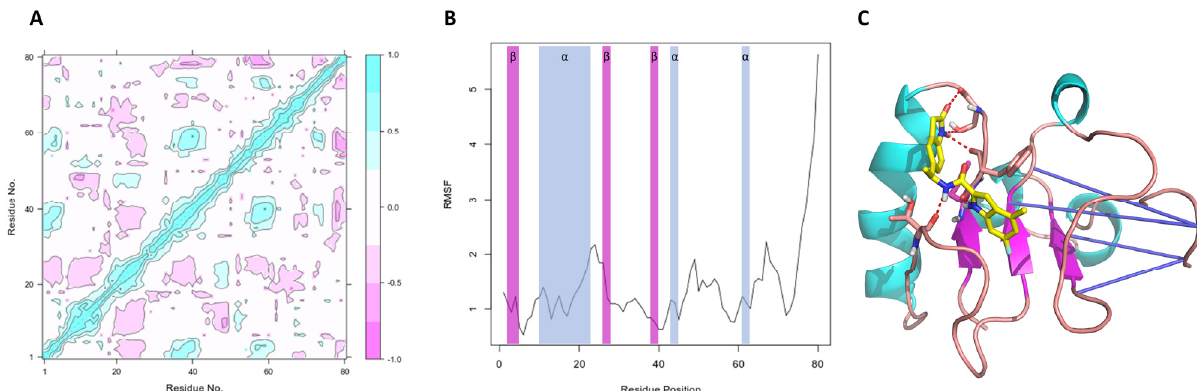
Figure 11. Analysis of Mult1_lr-CPE2 MD experiments. ( A ) Correlation matrix for all residues during the molecular dynamics simulation trajectory for multi_lr in complex with CPE2. ( B ) Root mean square fluctuation (RMSF, Å) for all the residues in the MD simulation of multi_lr in complex with CPE2. Blue-shaded regions corresponded to alpha helices, magenta-shaded regions corresponded to beta sheets. ( C ). Dynamic cross-correlation matrix (DCCM) vectors acting on the MD simulation of the structure of the complex of multi_lr and inhibitor CPE2 (in yellow). Hydrogen bonds are shown in red, alpha helices in cyan, beta sheets in magenta, and anticorrelation vectors in indigo.